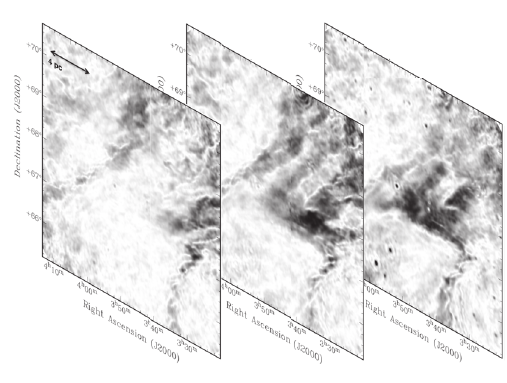
Figure 10. Illustration of Faraday tomography. Three slices, at Faraday depths Φ 1 = − 2 . 0 rad m − 2 , Φ 2 = − 1 . 5 rad m − 2 , and = − 1 . 0 rad m − 2 , through the Faraday cube obtained by [39] Φ 3 toward the Fan region, based on data from the LOFAR HBA at (115 − 178)MHz. Figure credit: Marta